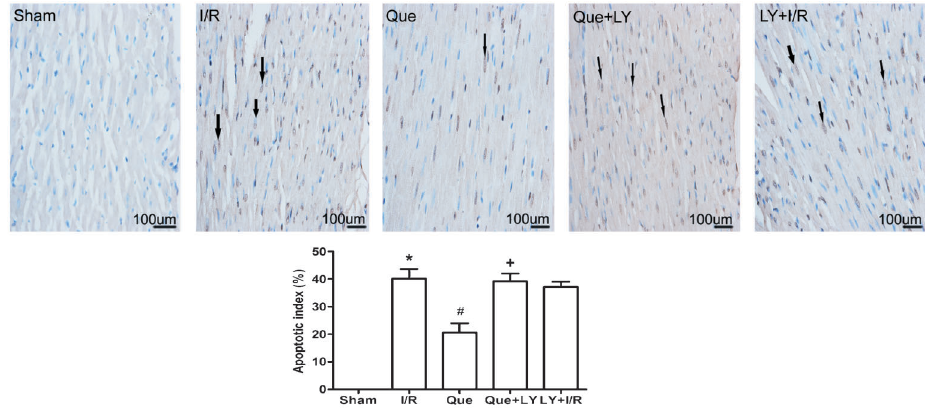
Figure 2. Effect of Que postconditioning on I/R-induced cardiomyocyte apoptosis determined by TUNEL (n=5). Arrows indicate TUNEL-positive cells. Data are reported as means±SD. Que: quercetin; I/R: ischemia/reperfusion; LY: LY294002; TUNEL: terminal dUTP nick end-labeling. *P , 0.05 vs sham group, # P , 0.05 vs I/R group, + P , 0.05 vs Que group (one-way ANOVA followed by the Bonferroni